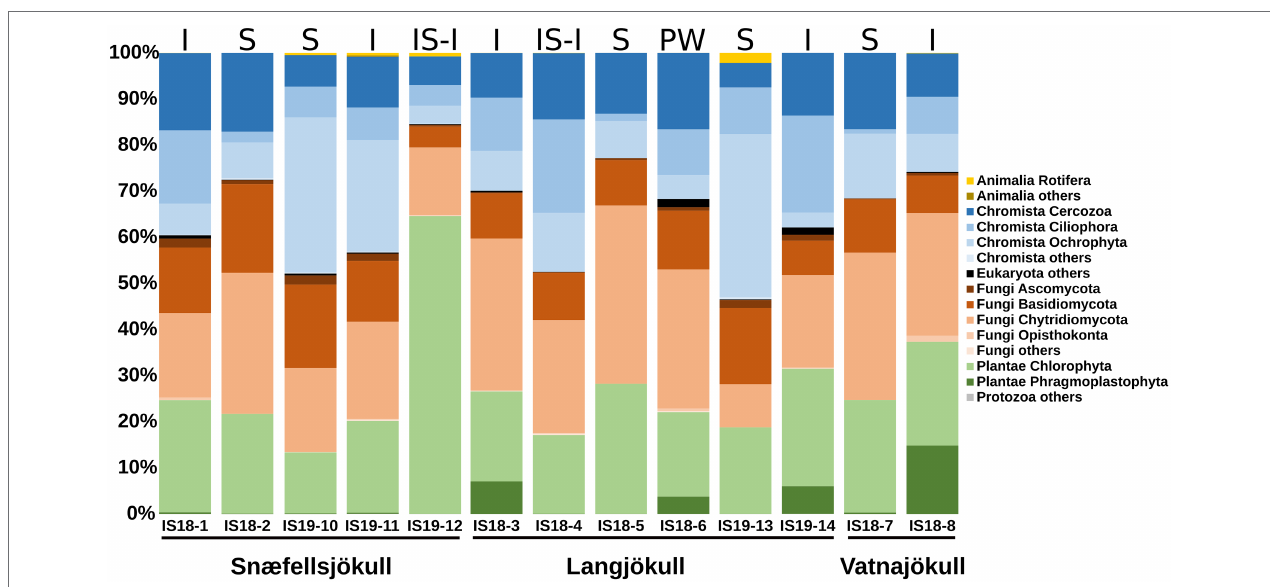
FIGURE 3 | Stacked bar plots showing 18S rRNA gene relative abundance at the phylum level. Samples are ordered chronologically for the each glacier. Letters above bars indicate habitat with I = ice, S, snow; SI-I, snow–ice interface; and PW, pro-glacial water and numbers below bars indicate sample number ( Table 1